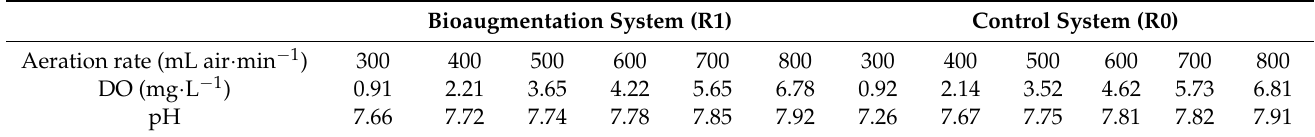
Table 1. Parameter setting of the reactors.